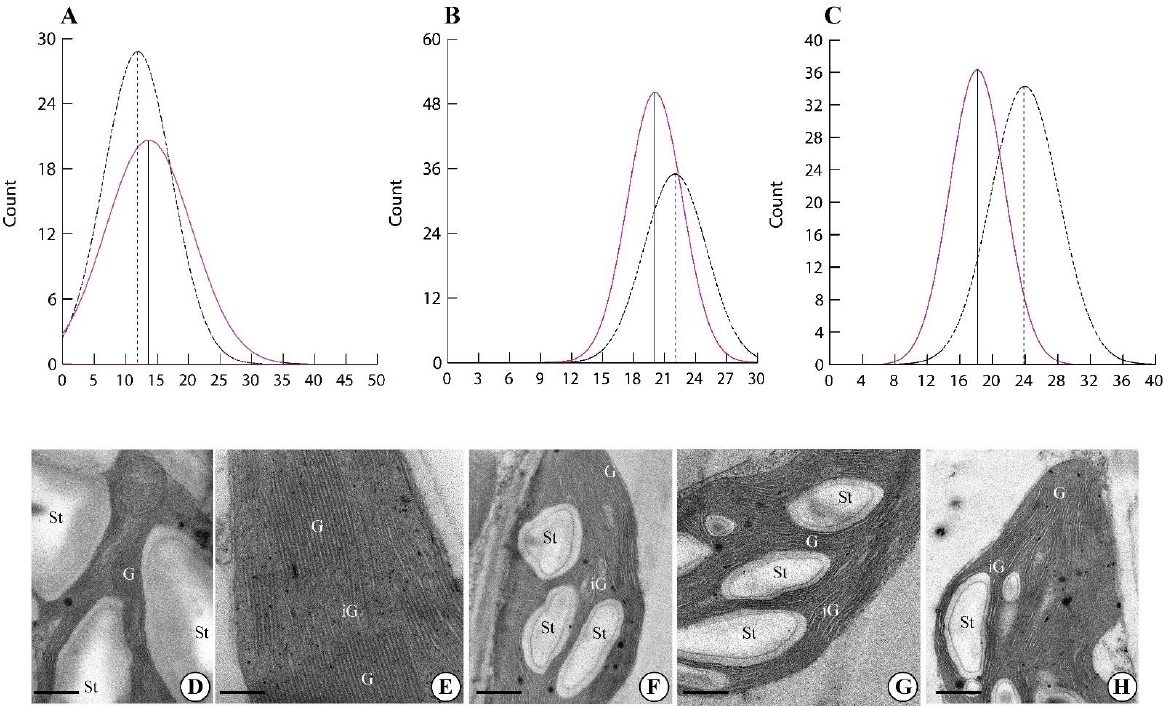
Figure 3. Morphometry of Lima bean chloroplasts in plants exposed to the GMF and NNMF. Density plots of the number of thylakoids per granum ( A ), granal thylakoid thickness expressed in nm ( B ) and intergranal thylakoid thickness expressed in nm ( C ). Dotted line, NNMF. Colored line, GMF. Ultrastructure of Lima bean chloroplasts in plants exposed to the GMF ( D , E ) and NNMF ( F – H ). G, granal thylakoids; iG, intergranal thylakoids; St, starch grain. Metric bars: ( D ), 1.50 µm; ( E ), 0.44 µm; ( F ), 1.20 µm; ( G ), 2.40 µm; ( H ), 2.40 µm.